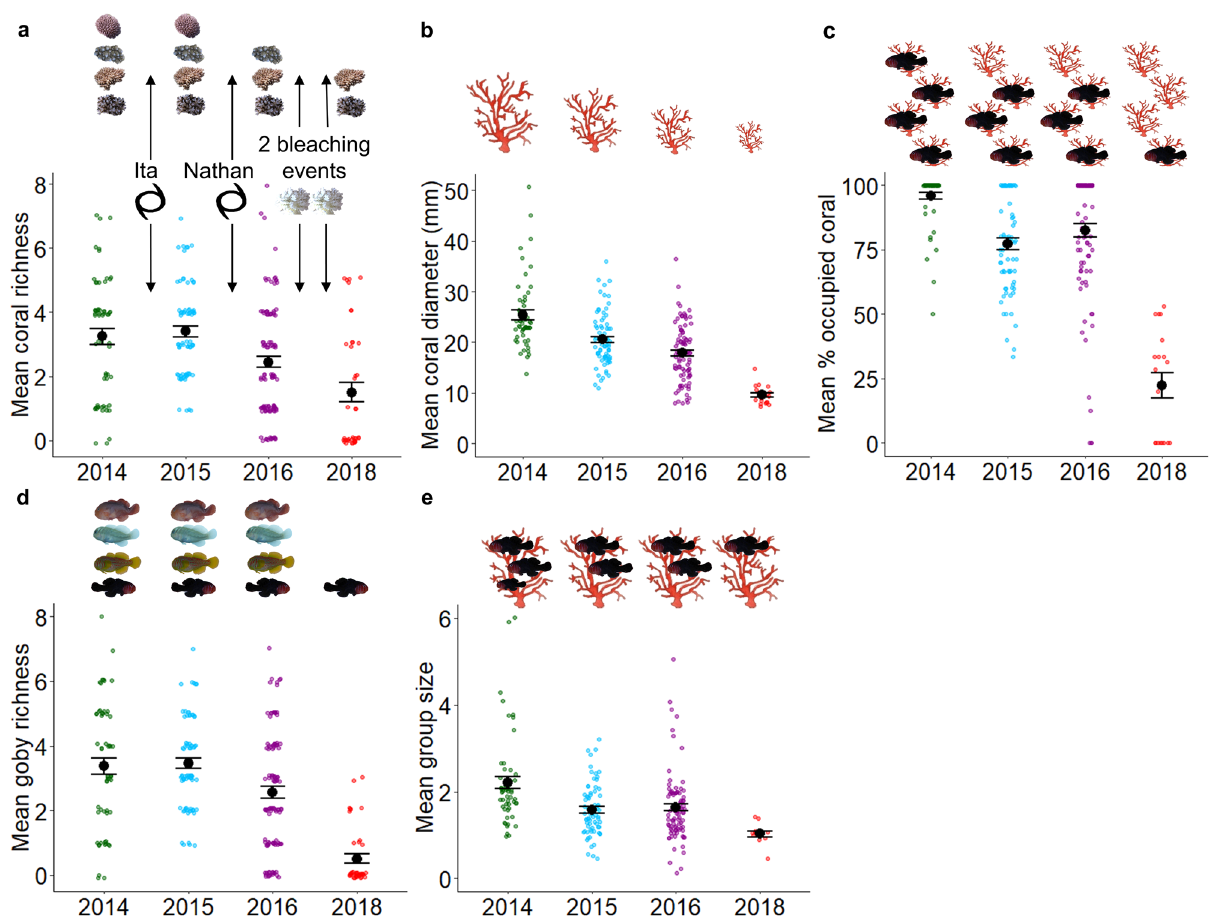
Figure 2. Effects of consecutive climate disturbances on coral and goby populations. Changes in Acropora ( a ) richness (n = 279), and ( b ) average diameter (n = 244), ( c ) percent goby occupancy (n = 244) and Gobiodon ( d ) richness (n = 279), and ( e ) group size (n = 230) per transect (n = sample size per variable) before and after each cyclone (black cyclone symbols) and after two consecutive heatwaves/bleaching events (white coral symbols) around Lizard Island, Great Barrier Reef, Australia. Error bars are standard error. Fish and coral symbols above each graph illustrate the change in means for each variable among sampling events from post-hoc tests. Figures were illustrated in R (v3.5.2) 33 and Microsoft Office PowerPoint